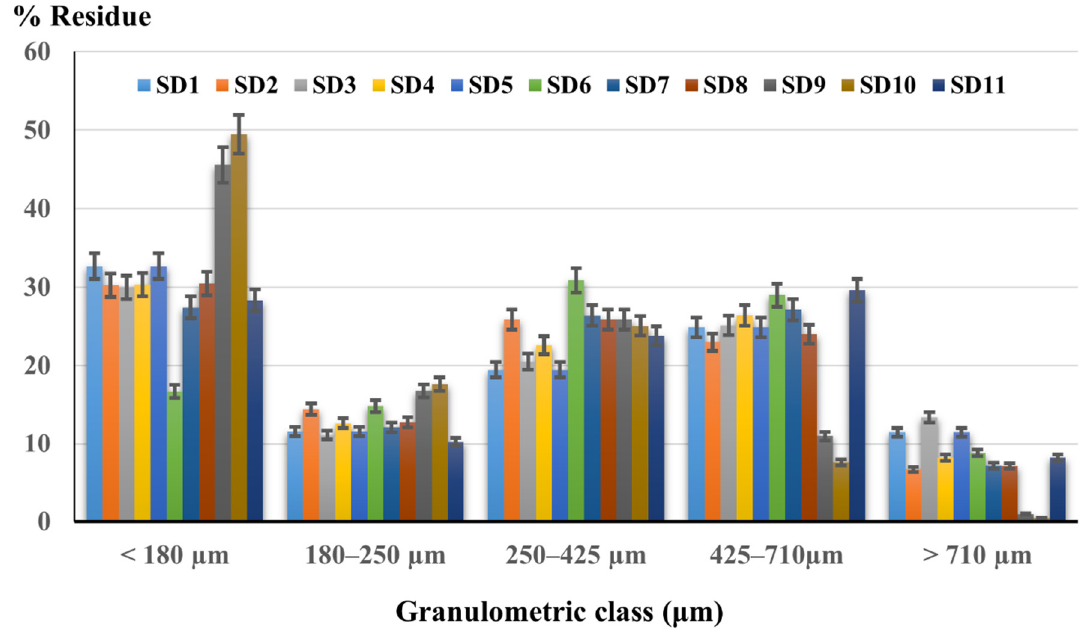
Figure 5. Granulometric analysis of solid